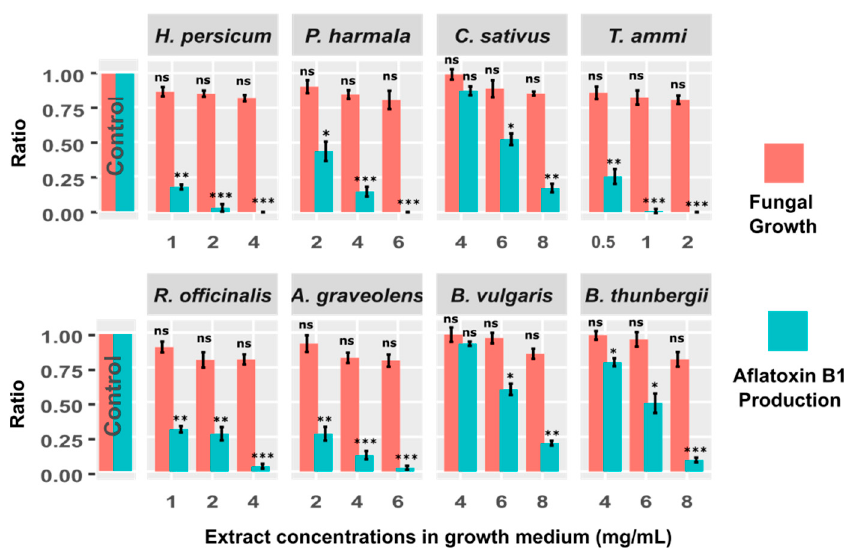
Figure 2. The effect of different concentrations of plant extracts (8 extracts in total) on growth of A. flavus NRRL 3357 and production of aflatoxin B1. Each bar shows the percentage of fungal growth (red bars) and aflatoxin B1 production (green bars) compared to control. To statistically assess the impact of these extracts on aflatoxin B1 production, we compared the aflatoxin B1 production between each of the treatment conditions (different plant extracts and doses) and the control using a two-sample t -test. Corresponding p -values are depicted above each bar (* p < 0.05; ** p < 0.01; *** p < 0.001; ns: not significant).